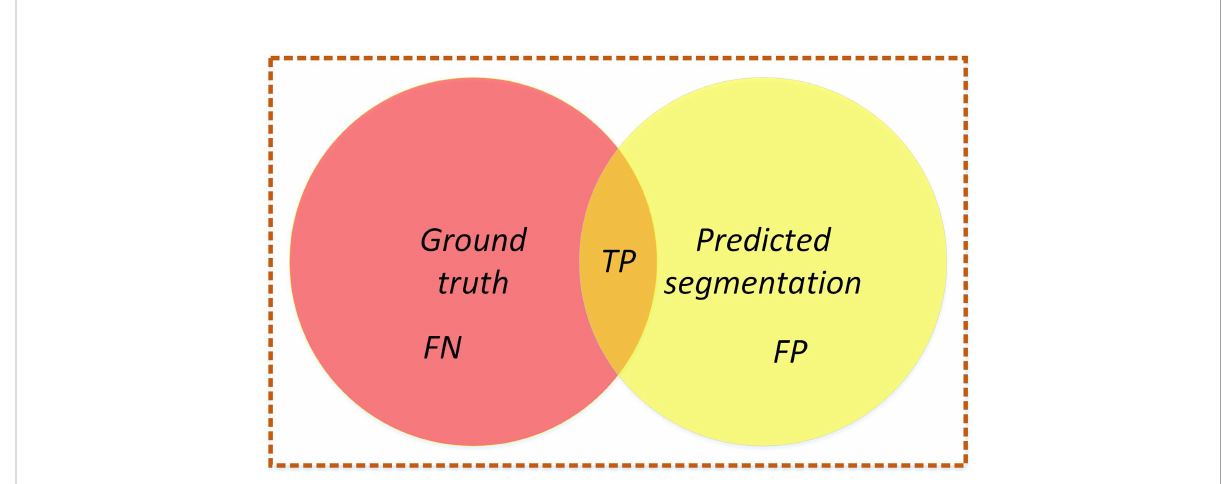
FIGURE 13 Intersection graph. The red circle represents the ground truth, the yellow circle represents the predicted segmentation, and the orange part is the intersection of the two circles. Calculate the ratio between the intersection of two circles (the orange part) and the union of two circles (red +orange+yellow). Ideally, the two circles coincide, and the ratio is